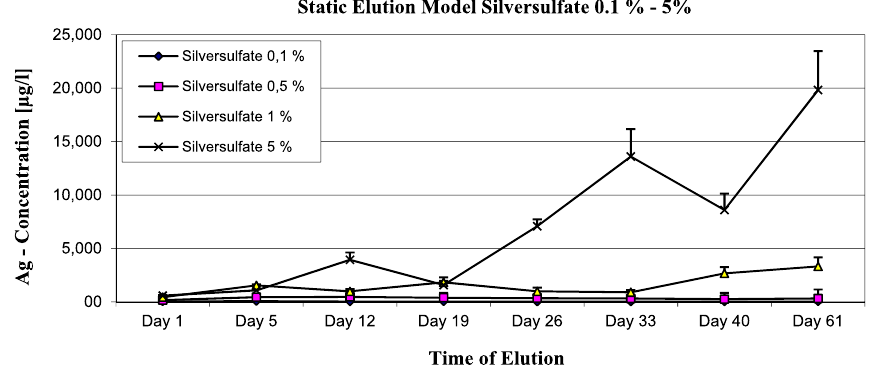
Figure 3. Silversulfate bone cement 0.1 to 5%—static elution model—max. Concentration of silver ions at 0.1% was 70.6 µg/l; at 0.5% was 455.5 µg/l; at 1% was 3321.4 µg/l and at 5% the max. Concentration was 19,826 µg/l.